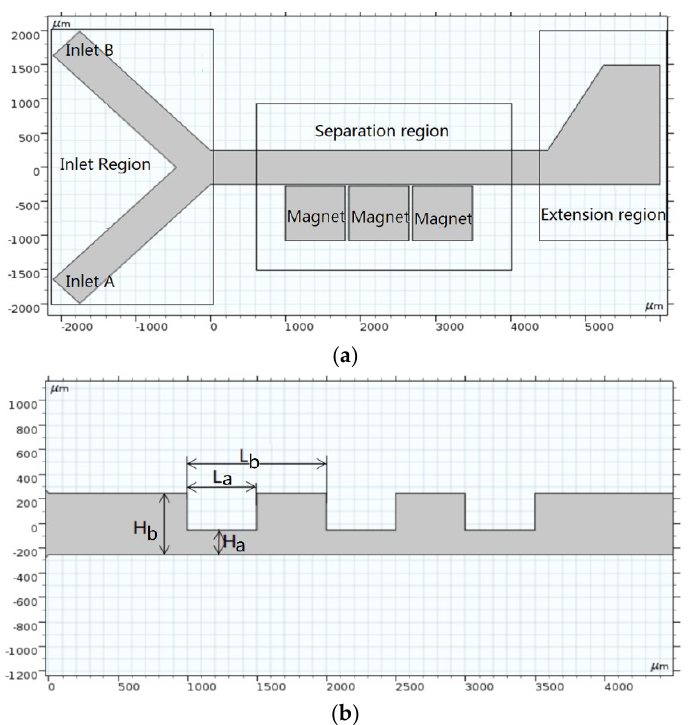
Figure 2. ( a ) Schematic diagram and ( b ) geometrical dimensions of the negative magnetophoretic sorter.